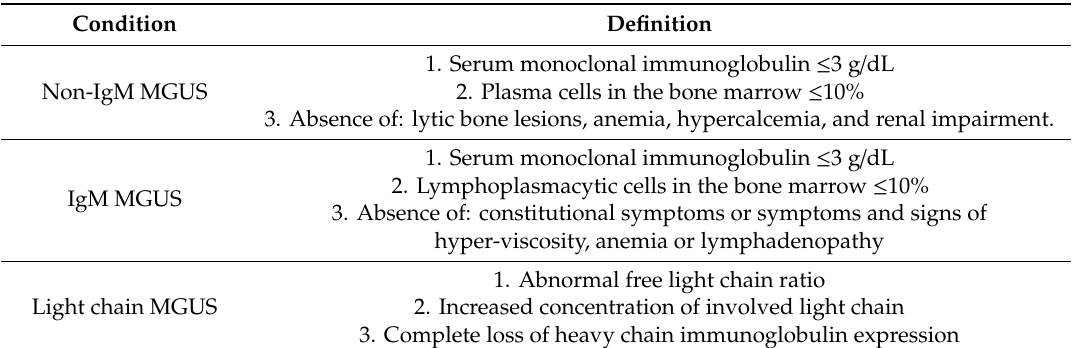
Table 1. Summary of diagnostic criteria for monoclonal protein